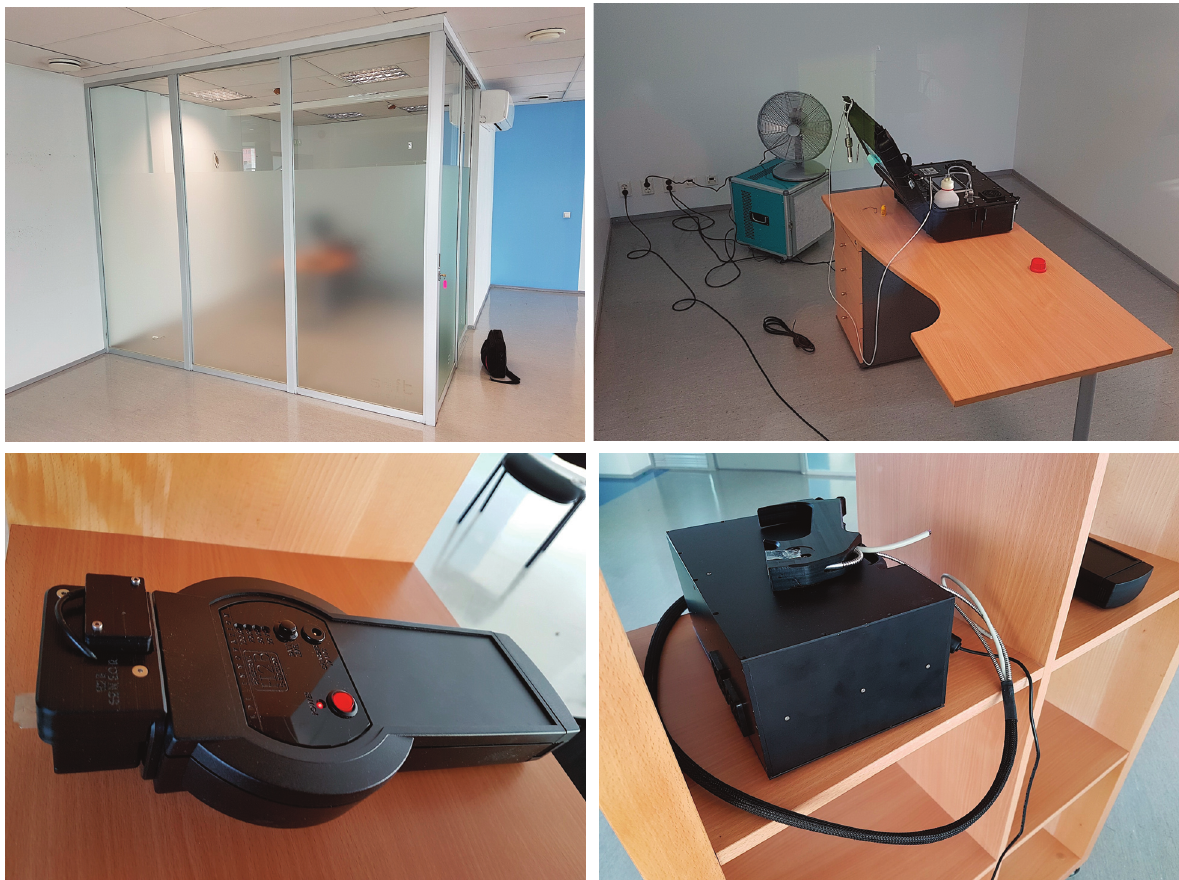
Fig. 1. Top left – a side view of the rented conference room with a volume of 30 m 3 in the unused office building, used in the experiments. Top right – a view inside the experimental room: the big box, in light blue colour, on the floor is the VHP catalyser, the black suitcase on the table is the VCS-100 VHP generation device with the VHP sensor hanging from the lid; the larger fan for air homogenisation is not visible in the picture. Bottom left – a top view of the H2B-Spectral fluorometer with a stainless steel sample disk inserted. Bottom right – a side view of the SFS-GO spectrofluorometer with the sample installed in the measurement handle on top of the